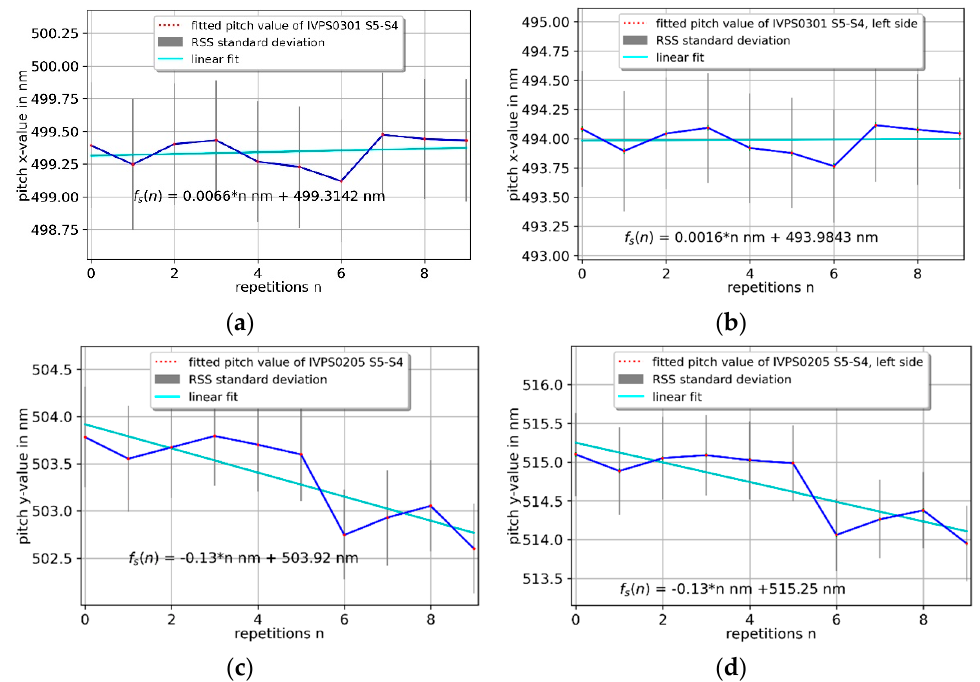
Figure 15. Pitch measurement of the left sidewall with the 3D-Nanoprobe of two orthogonal mounted IVPS100-PTB structures (IVPS0301 ( a ), ( b ) and IVPS0205 ( c ), ( d )), showing hinds of asymmetric tip wear in y-direction by comparing ( c ) and ( d ).